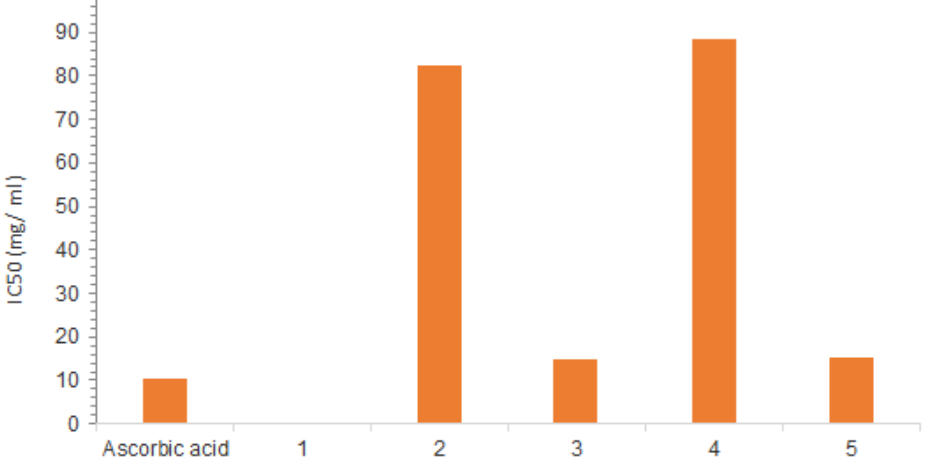
Figure 17. Variation of IC50 values for all complexes and standards.